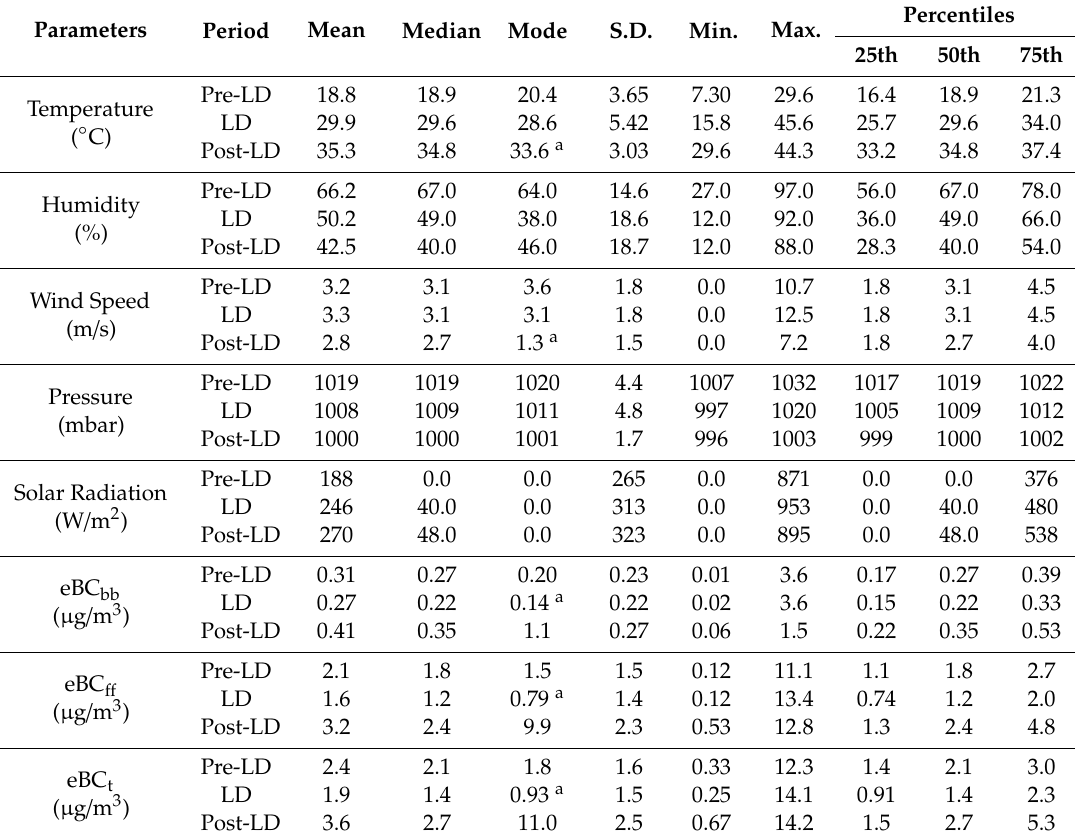
Table 1. Descriptive statistics of the measured parameters during Pre-LD, LD, and Post-LD.